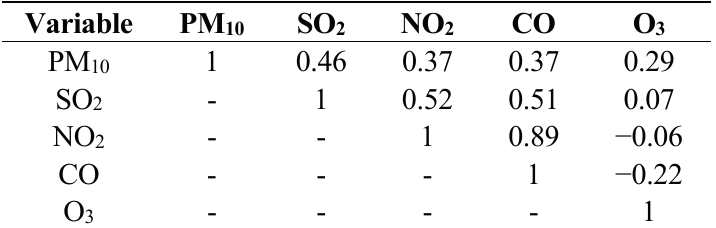
Table 2. Correlation coefficients among air pollutants.